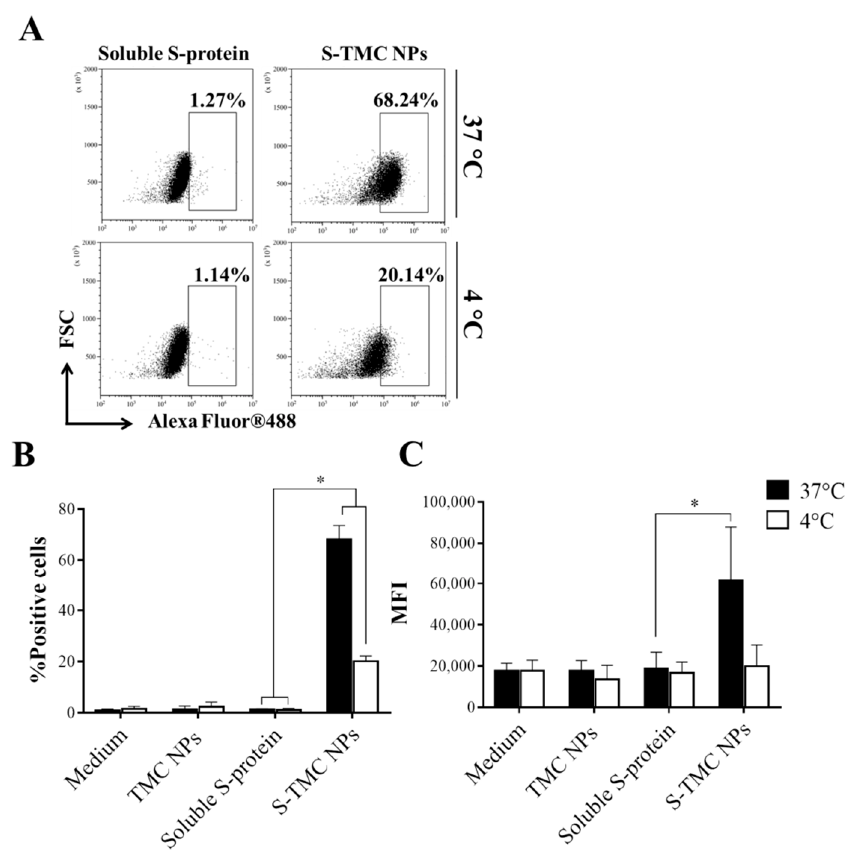
Figure 2. Cellular uptake of S-TMC NPs by phagocytic cells. Cultures of THP-1 cells were incubated with S-TMC NPs (20 µ g/mL) or soluble S-protein (20 µ g/mL) at 4 ◦ C or 37 ◦ C for 4 h. Intracellular S-antigens were detected by antibody staining with rabbit anti-SARS-CoV-2 antibody and analyzed by flow cytometry; ( A ) dot plot analysis, ( B ) the percentage of S-protein positive cells and ( C ) mean fluorescent intensity (MFI). The results are shown as means ± SD (n = 5); * indicates a significant difference between the soluble S-protein and the S-TMC NP treatment ( p < 0.05).